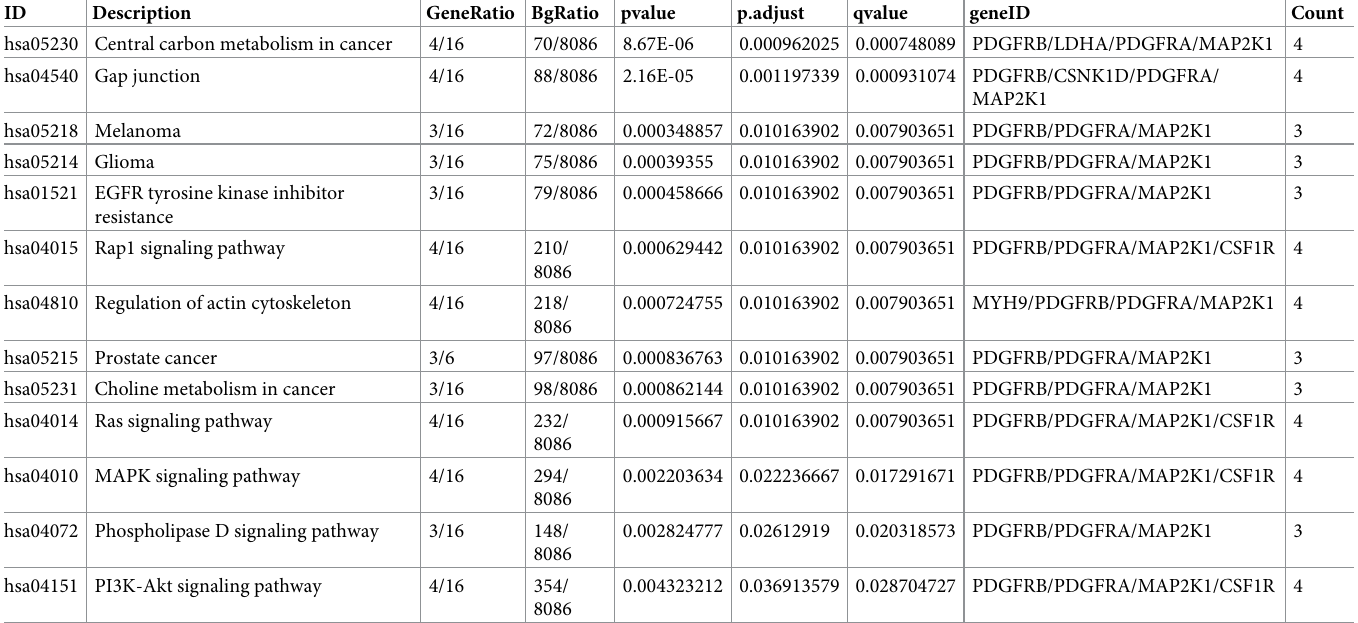
Table 2. KEGG enrichment